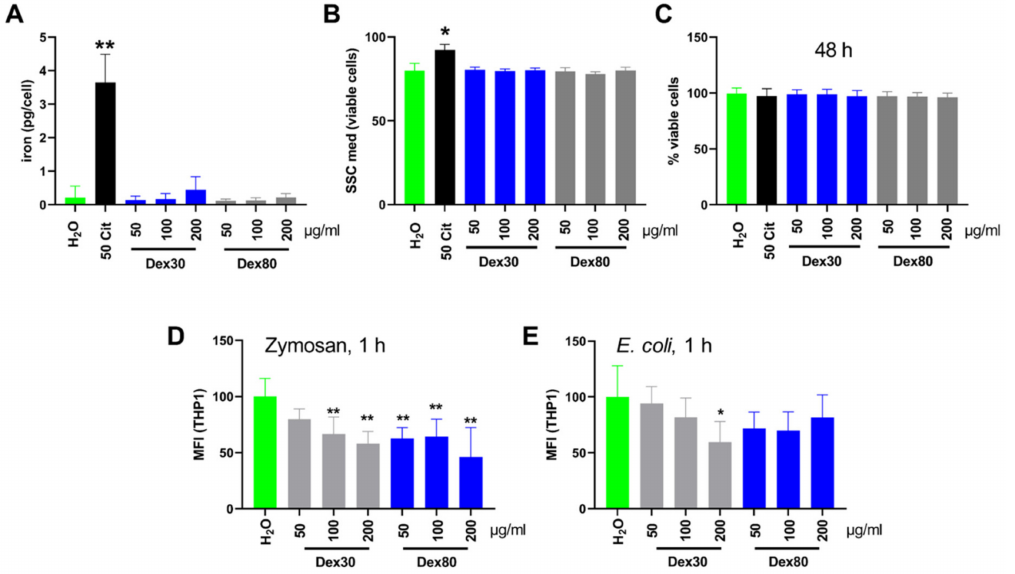
Figure 3. The effect of 30 nm and 80 nm SPION Dex on the THP-1 cells. The THP-1 cells were incubated with 50, 100 and 200 µ g/mL SPION Dex30 and SPION Dex80 or SPION Cit , serving as a positive control. The nanoparticle uptake by the cells was determined by atomic emission spectroscopy ( A ) or side scatter in flow cytometry ( B ). The viability of the THP-1 cells was determined after 48 h of nanoparticles incubation by AxV and PI staining in flow cytometry. The AxV-PI-cells can be regarded as viable. The amount of viable cells in the negative control (H 2 O) was set to 100% and viability calculated accordingly ( C ). ( D , E ) Opsonized fluorescent-labelled Zymosan A and E. coli were added to THP-1 preincubated with SPION Dex . Phagocytosis by the THP-1 cells was estimated using their mean fluorescence index. The experiment was performed in three ( A – C ) or two ( D , E ) independent triplicates. The mean values with standard deviations are shown. Significance was analyzed using a Kruskal–Wallis test (** p ≤ 0.01, * p ≤